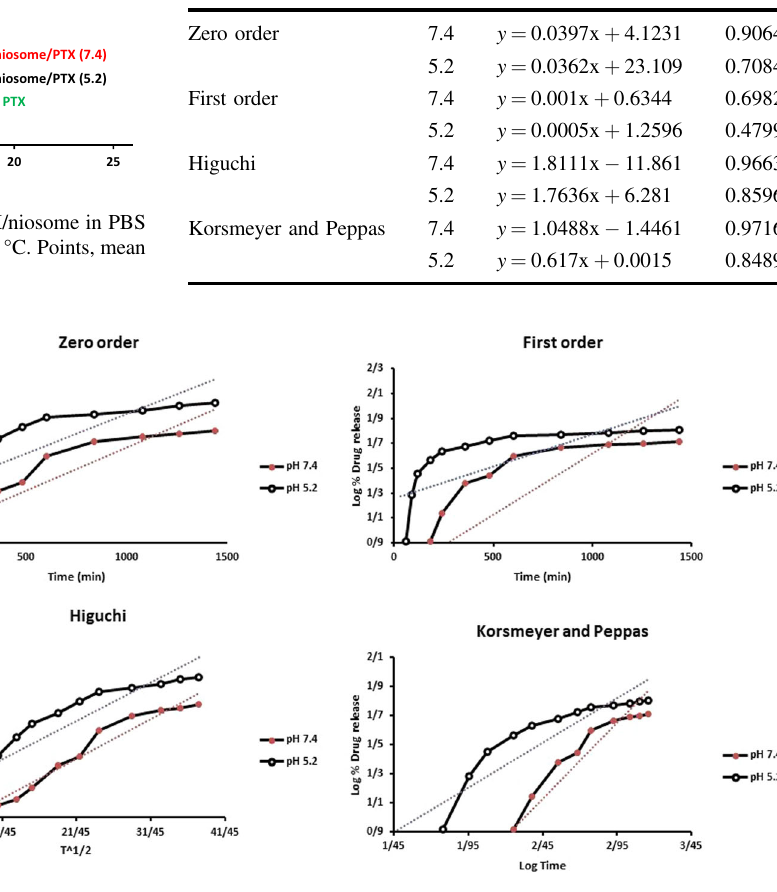
Table 2 Kinetic models (linearized equations) of PTX released from pH-responsive niosomes at pH 7.4 and 5.2 Kinetic model